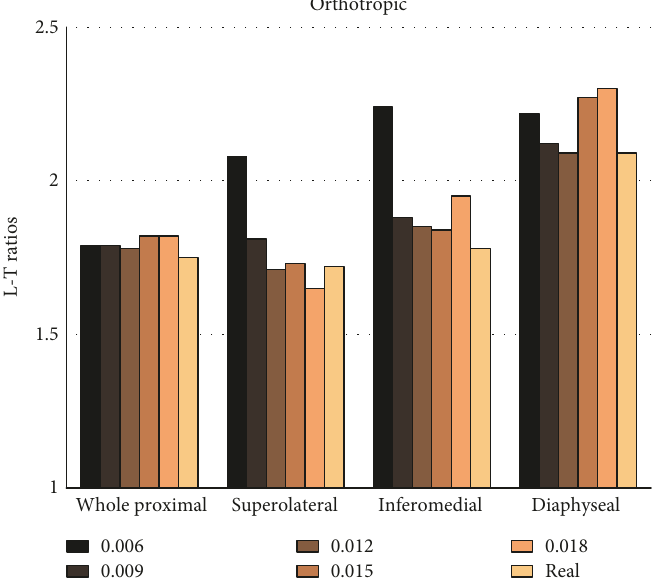
Figure 5: The simulated L-T ratios in the local regions of the proximal femur, which were calculated by the orthotropic material algorithm. The real L-T ratios derived from literature [34] are also illustrated for